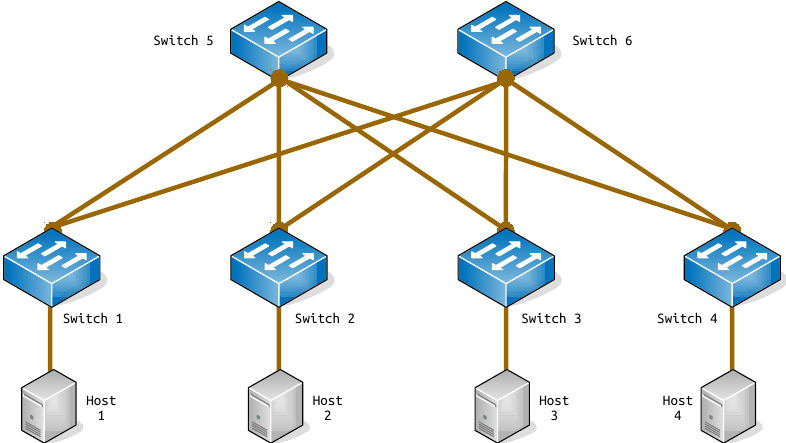
Figure 6. An example network ( DC NET ) with data center